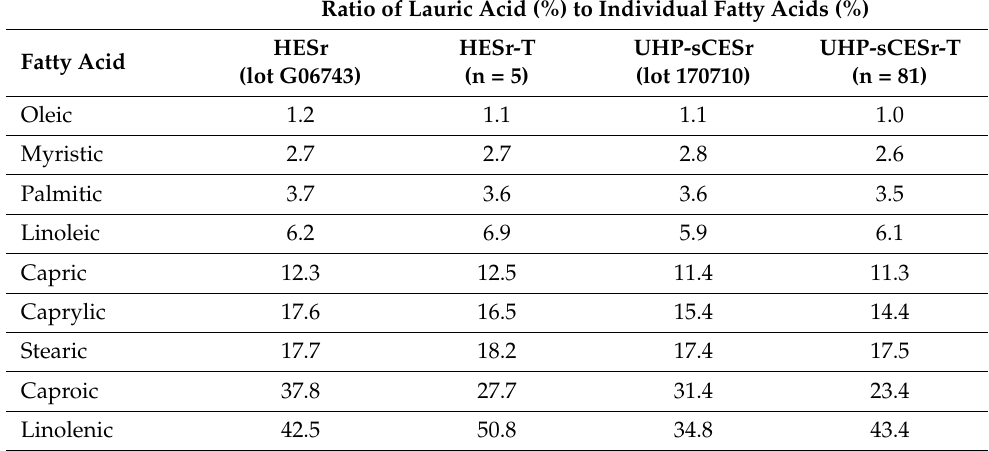
Table 1. Lauric acid ratios for individual fatty acids in HESr, HESr-T, UHP-sCESr, and UHP-sCESr-T. Ratio of Lauric Acid (%) to Individual Fatty Acids